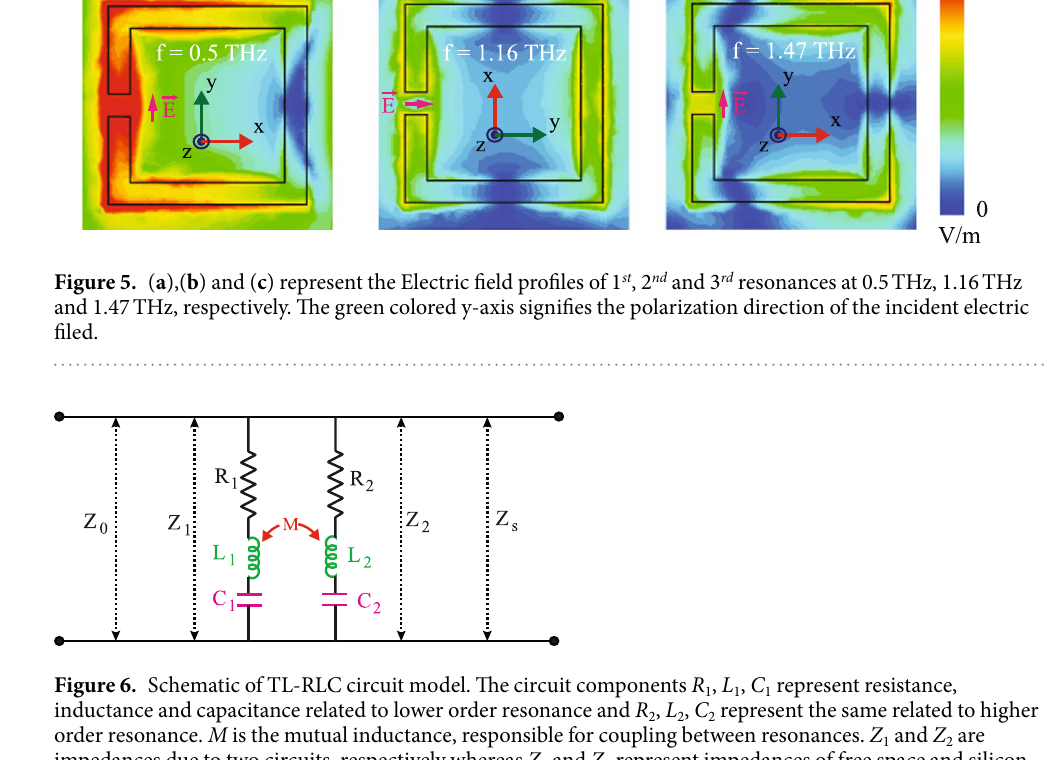
The results of the transmittance from the model are shown in Fig. 7(a) and (b). Figure 7(a) corresponds to 1 st and 3 rd order resonances whereas Fig. 7(b) corresponds to 2 nd order resonance. In the figure different coloured plots correspond to transmittance from the TL-RLC circuit model for different analyte thicknesses. It is noticed that they predict a similar resonant behaviour and confirm our numerically simulated results for certain values of resistance, inductance, capacitance and mutual inductance for typical SRR design. The details of the analytical transmission line model are as follows: We assumed SRR as an equivalent RLC circuit where it is typically considered that split gap corresponds to the capacitive part, the SRR loop corresponds to the inductive part and the internal reactance of SRR is represented by the resistance part. Our numerical findings show us three resonances, 1 st and 3 rd order resonances in together for polarization parallel to split gap and 2 nd order resonance alone for polarization perpendicular to the gap. The res- onant frequencies of a RLC circuit model always inversely depend on the square root of the product of inductance